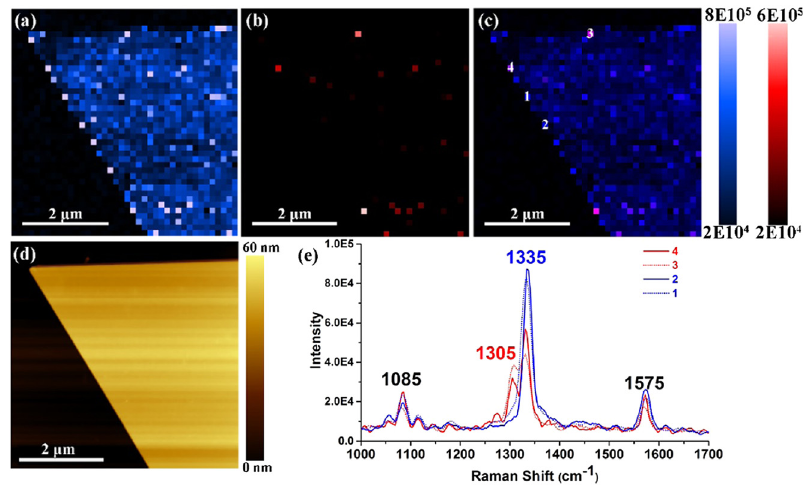
Figure 10: TER images of 4NBT monolayer on gold Au (111) surface. (a)and(b)visualrepresentationsofintegral